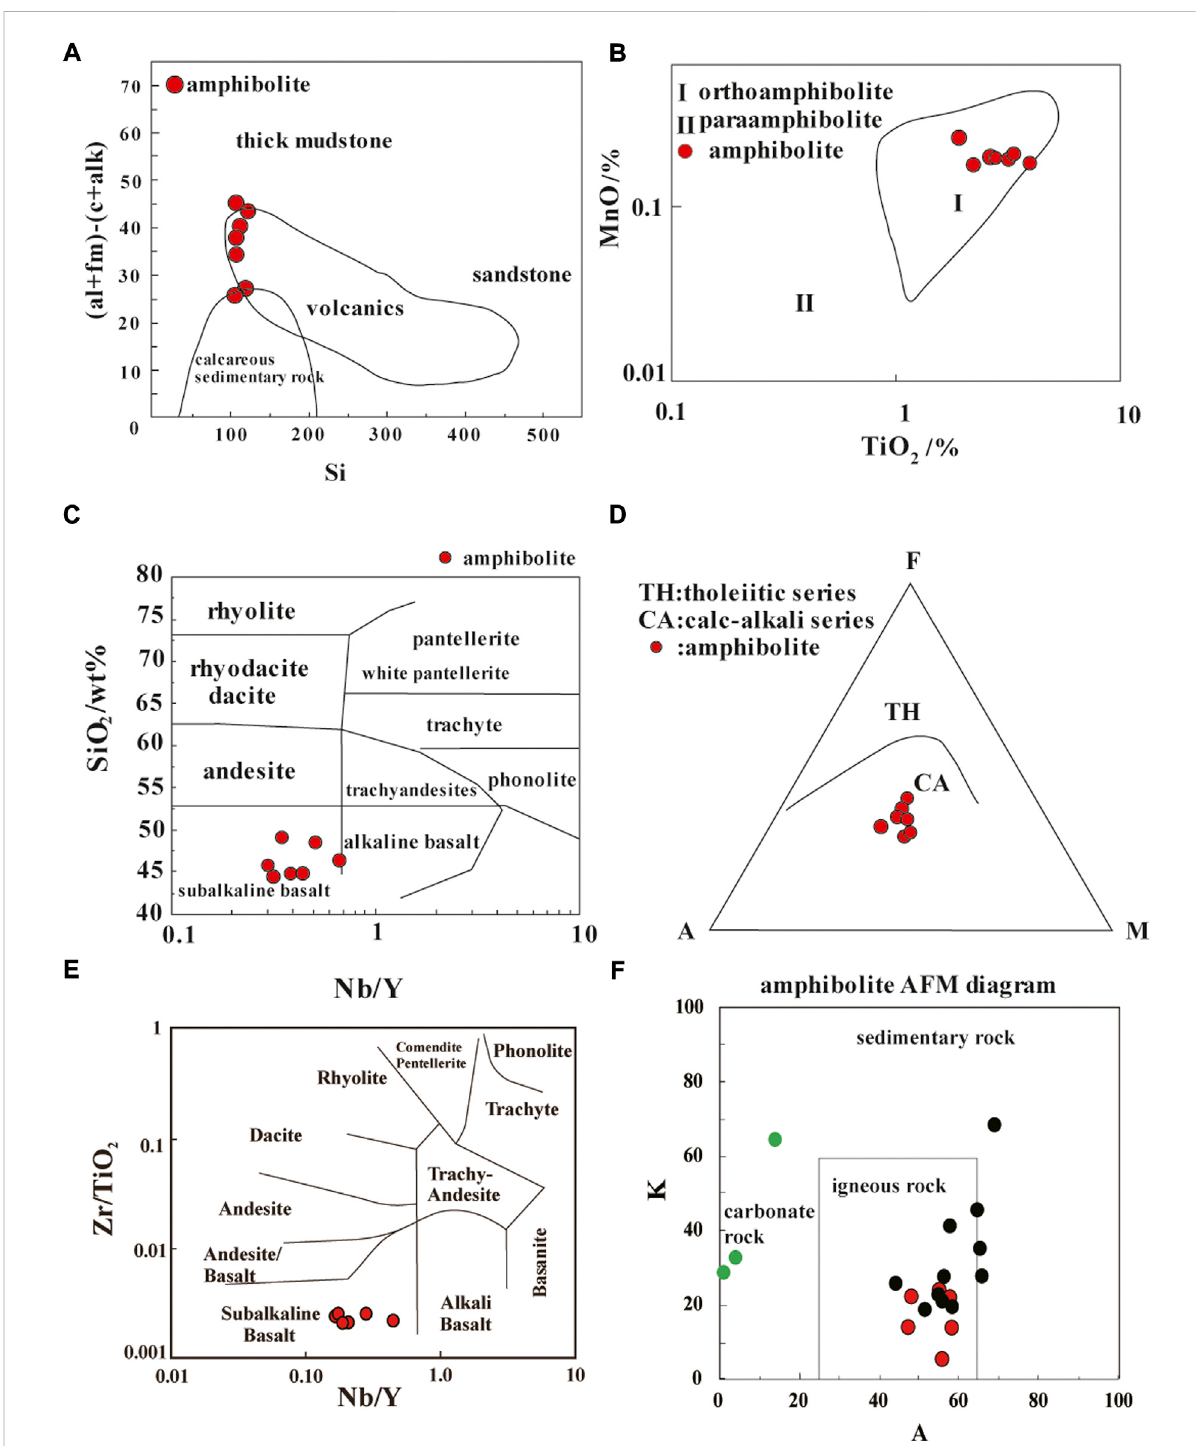
FIGURE 5 (A) (al + fm)-(c + alk)-si diagram; (B) MnO – TiO 2 diagram; (C) SiO 2 -Nb/Y diagram; (D) AFM diagram; (E) Zr/TiO 2 ×0.0001-Nb/Y; and (F) A-K diagram. The black circle represents the schist, and the green circle represents the marble. (after Simomen (1953), Irvine and Baragar (1971), Winchester and Floyd (1977), Wang (1987), Liu (1988), and Chen et al.